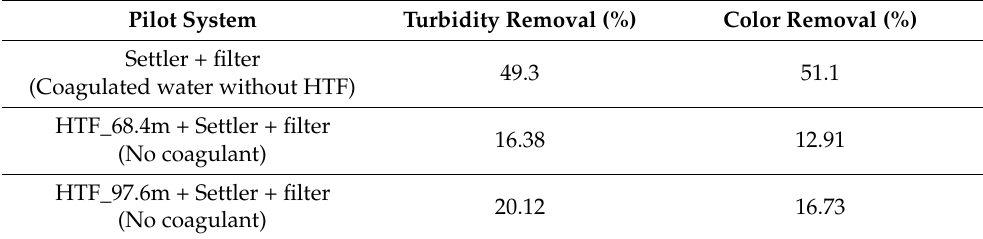
Table 13. Turbidity and color removal in control